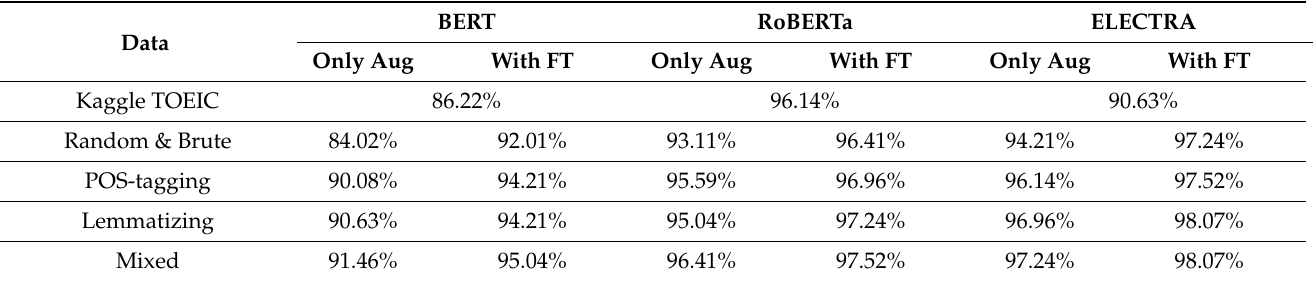
Table 5. Experimental results on Kaggle TOEIC data, Randomly and Brutely Augmented Data, POS-tagging Based Data, Lemmatizing Based Data, and Mixed